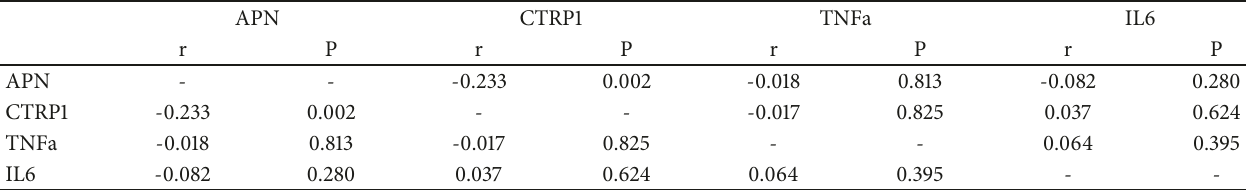
Table 6: Pearson analysis of the association among CTRP1, APN, TNF- 𝛼 , and